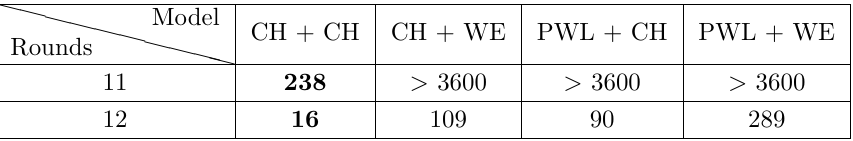
Table 9: Solving times for Skinny64 over 11 and 12 rounds depending on the modeling. Timings are given in seconds over a subset of all